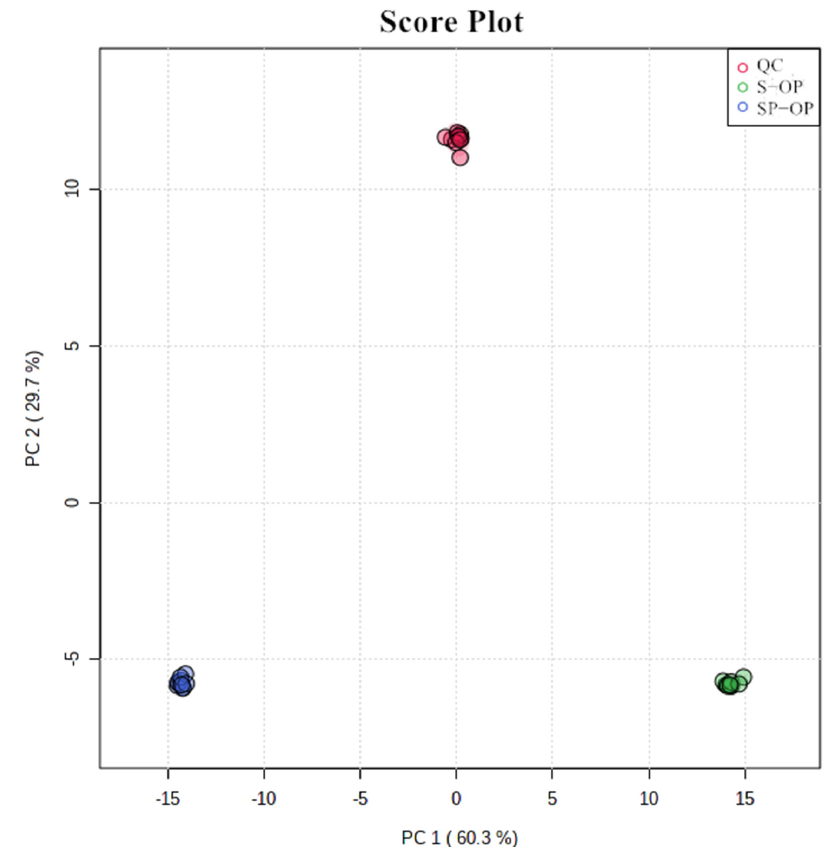
Figure 2. PCA score plots of the soup samples and the QC sample.